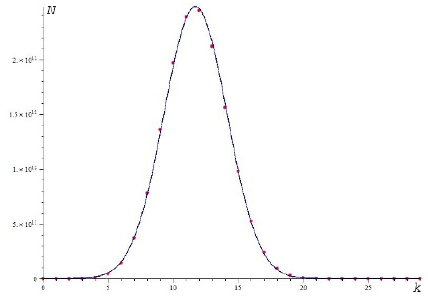
Figure 1 . Red dots are N numbers, blue curve is a Gaussian distribution with parameters [4] ; (cid:0) 20 ;k (cid:22) = 10 : 6 ; (cid:27) = 2 : 24 ; I = 4 : 56 (cid:1) 10 10 .